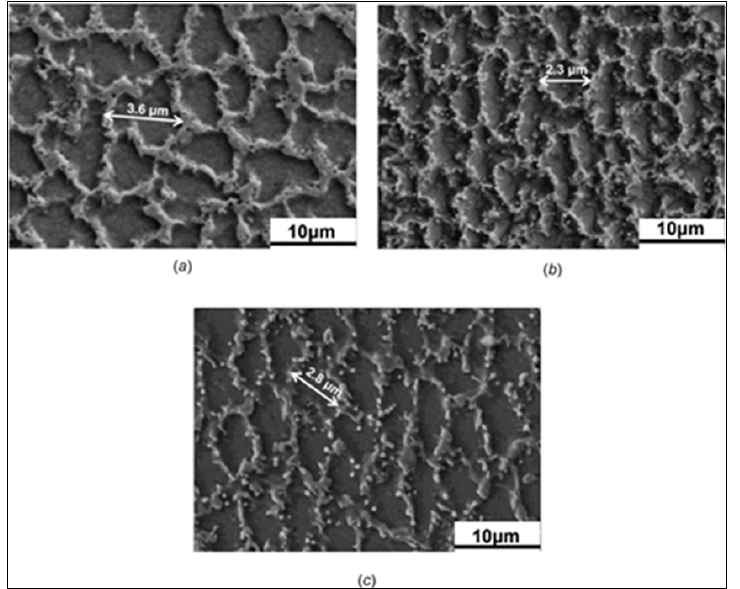
Figure 23. FE-SEM images showing the cellular microstructures in DLD-processed Inconel 625 and TiC/Inconel 625 composites. ( a ) Unreinforced Inconel 625; ( b ) Inconel 625 + nano-TiC; and ( c ) Inconel 625 + micro-TiC (adapted with permission from Ref. [57] 2017, ASME.